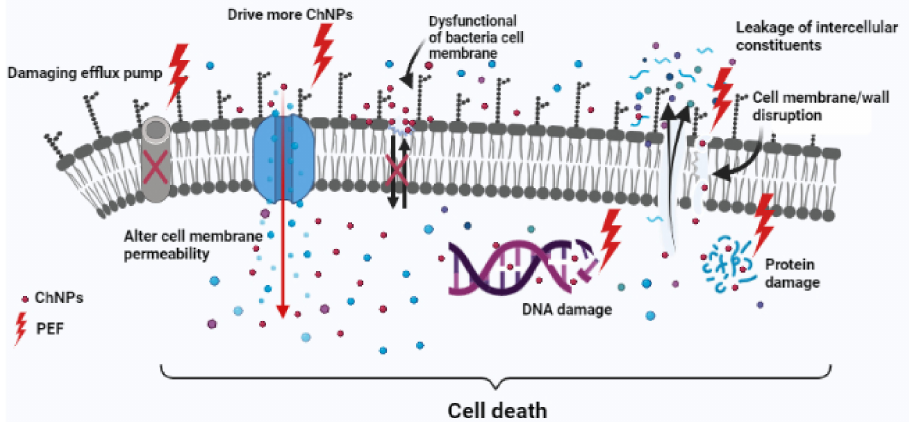
Figure 12. Schematic diagram of possible antimicrobial synergism of ChNPs and PEF against bacterial